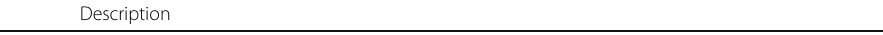
Table 4 STEM schools design principles Principle